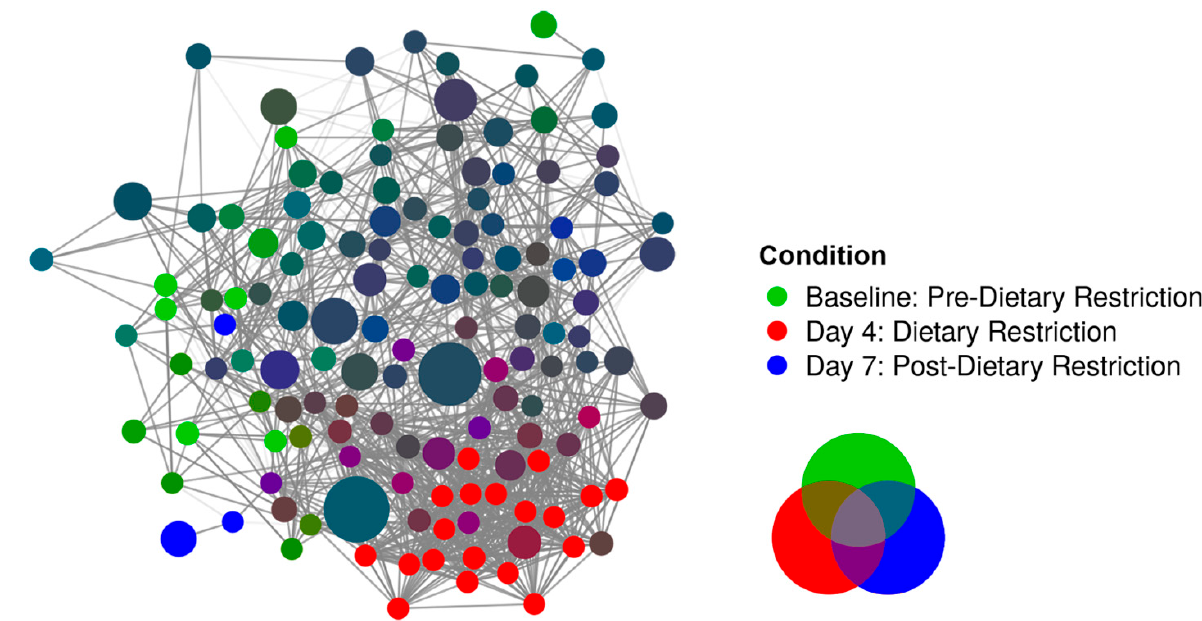
Figure 4. Network analysis of high prevalent species. A total of 136 high prevalent species are depicted by individual nodes, and each node color represents relative abundance by condition. Edges are significant species correlations ( p < 0.05). Edge intensity depicts the value of the correlation coefficient.